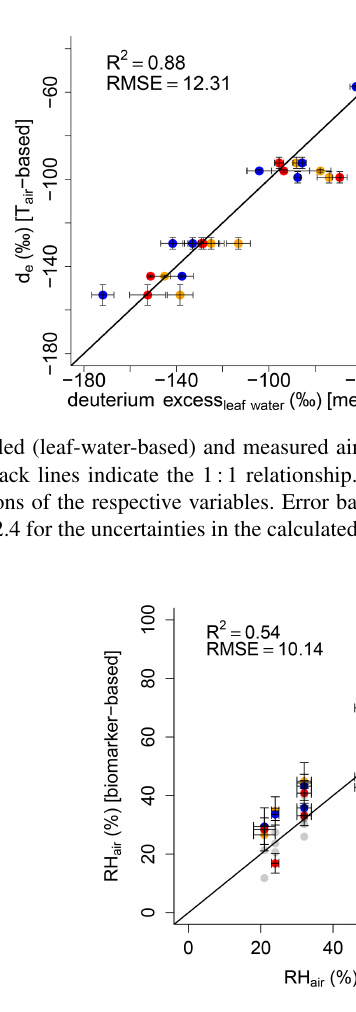
Figure 8. Scatterplot depicting the relationship between modeled (biomarker-based) and measured relative air humidity (RH air ). The black line indicates the 1:1 relationship. R 2 and RMSE was cal- culated as described in Sect. 2.4, while the RMSE values have the dimensions of the respective variables. Error bars for the measured values represent analytical standard deviations (see Mayr, 2002). For uncertainty calculation of the results, see Sect. 2.4. In addition, the leaf-water-based relative air humidity results are shown in light gray for